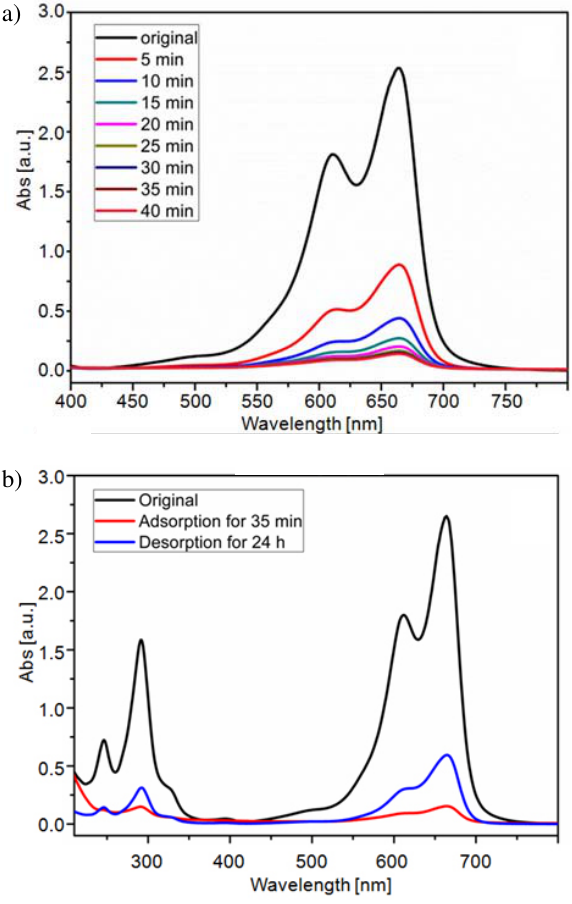
Figure 5. (a) The UV-vis absorption spectra of MB under different time by MnO /ESM adsorption. (b) The UV-vis absorption spectra 2 of MB by adsorption for 35 min and desorption for 24